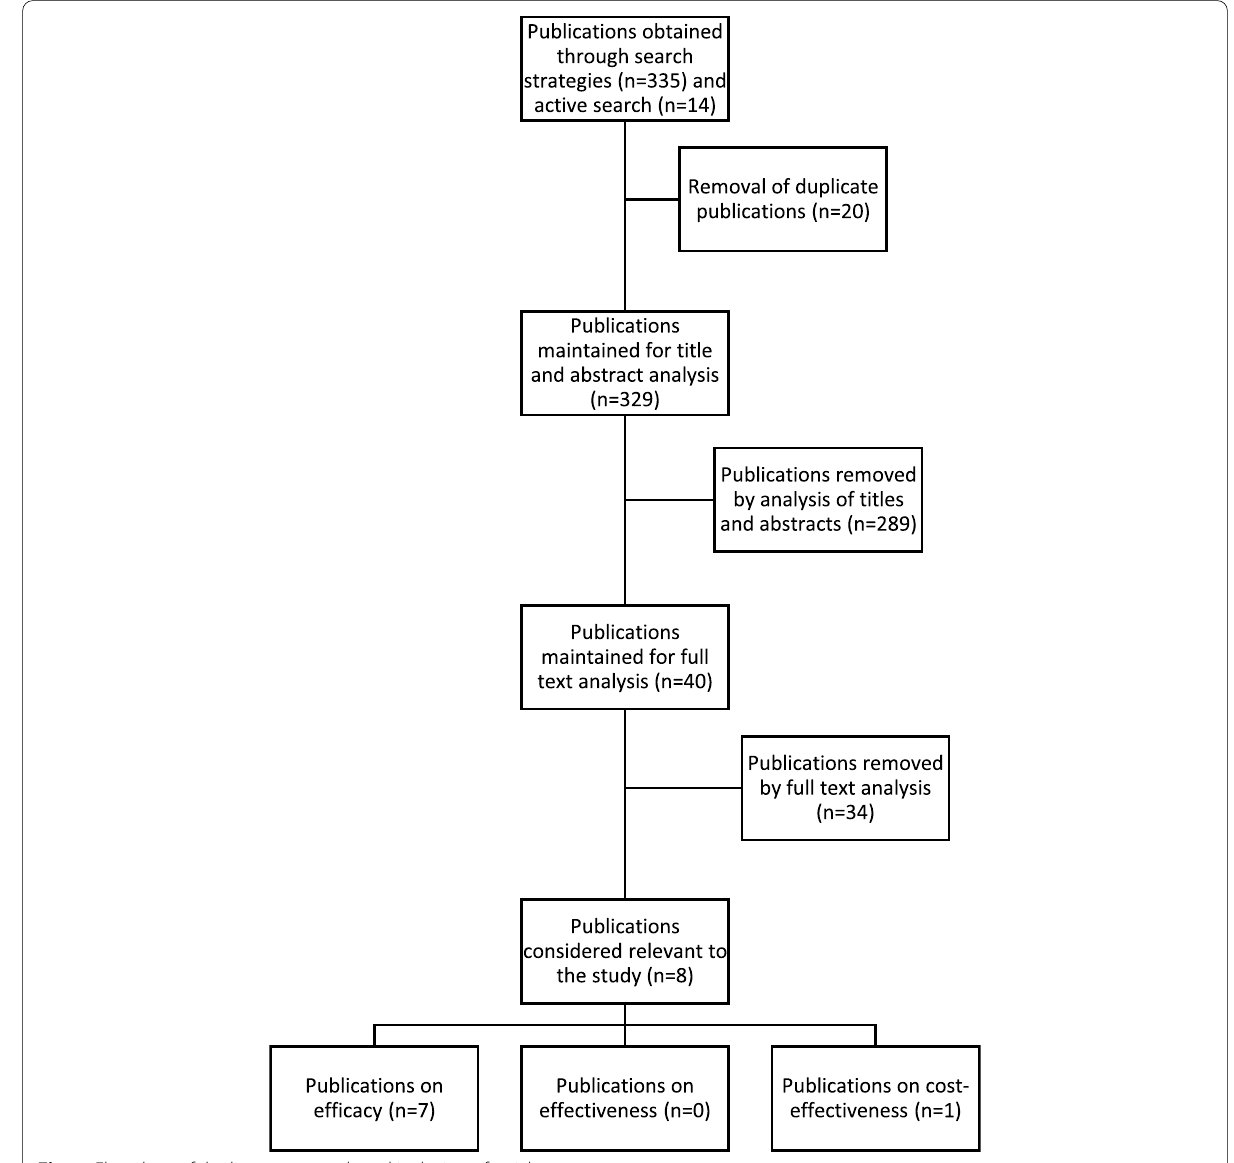
Fig. 1 Flowchart of the literature search and inclusion of